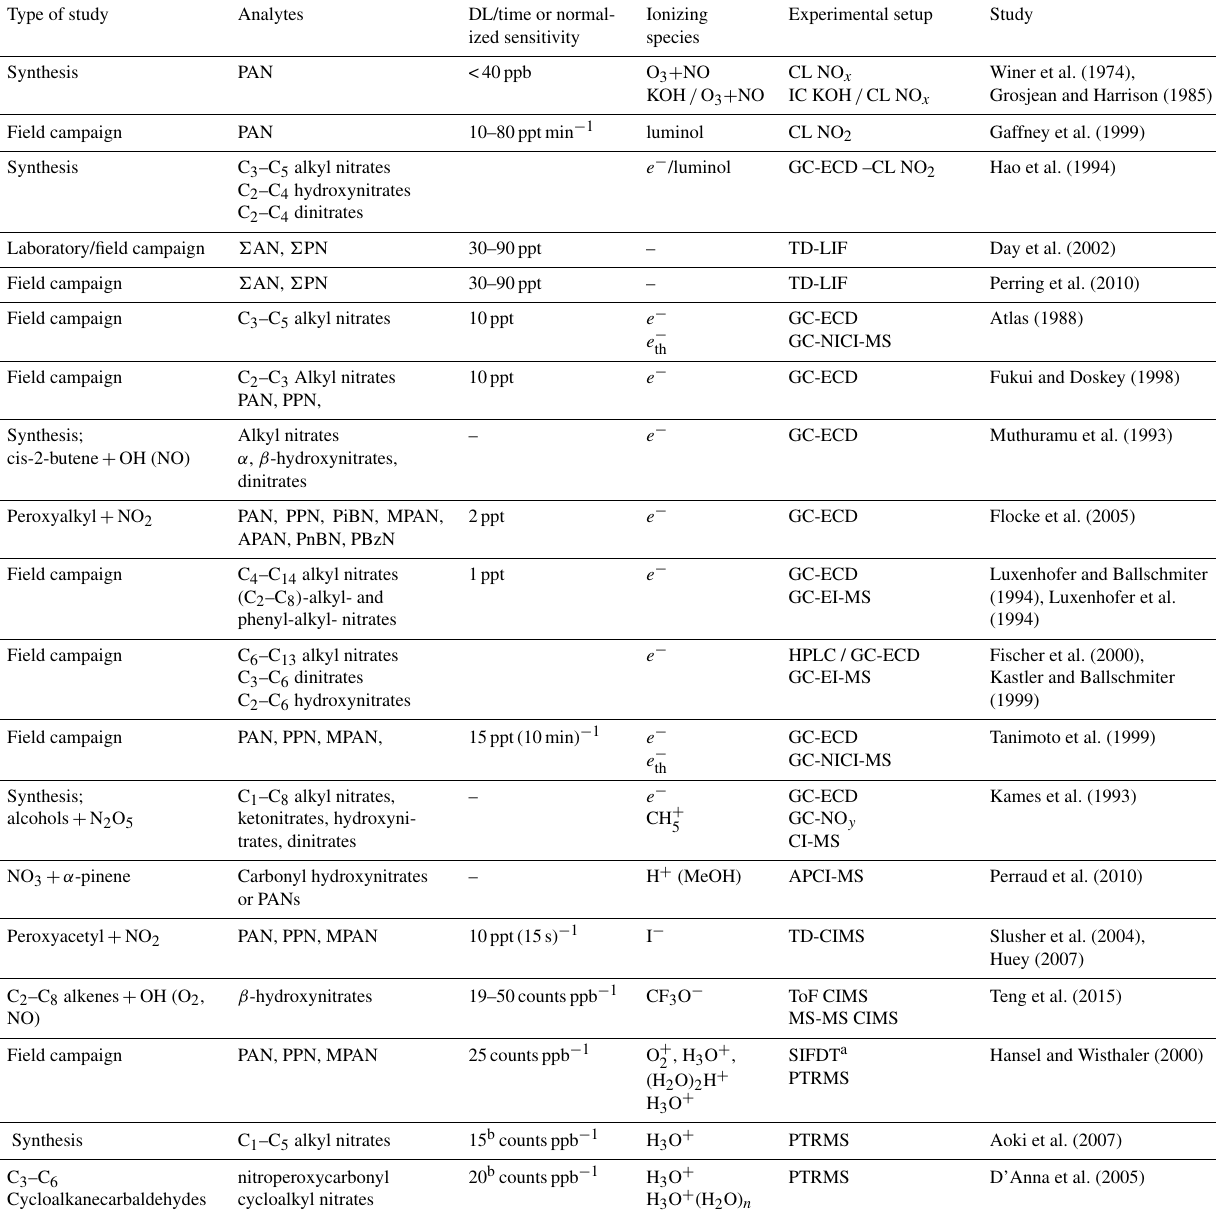
Table 1. Summarized analytical approaches into the organic nitrate